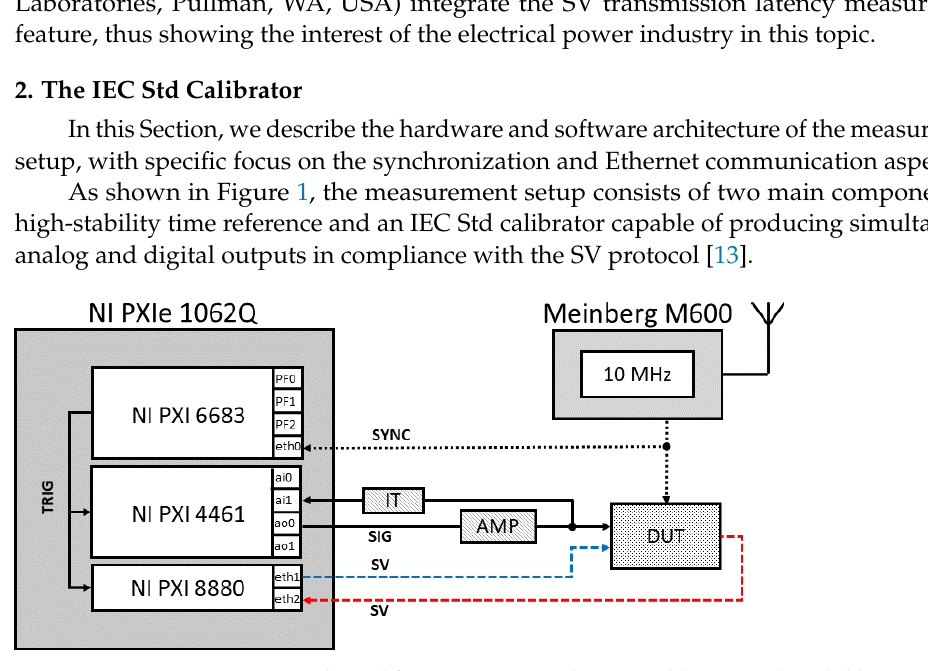
Figure 1. Measurement setup adopted for IEC 61850-9-2 devices’ calibration. The solid lines represent analog signals, the dotted lines represent synchronization logic signals, and the dashed lines represent the published and the received SV data streams in blue and red,